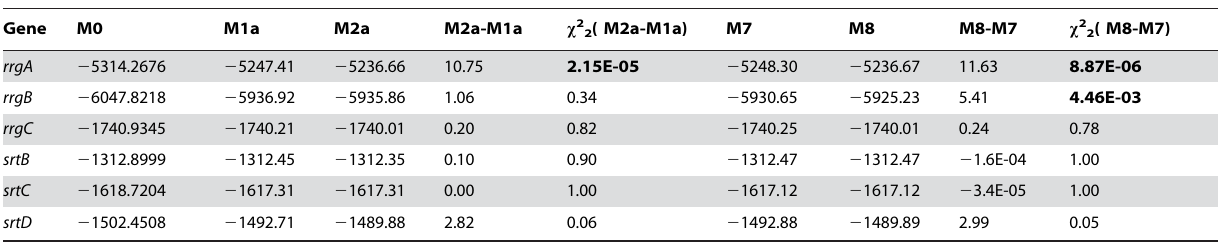
Table 2. Tests of positive selection.